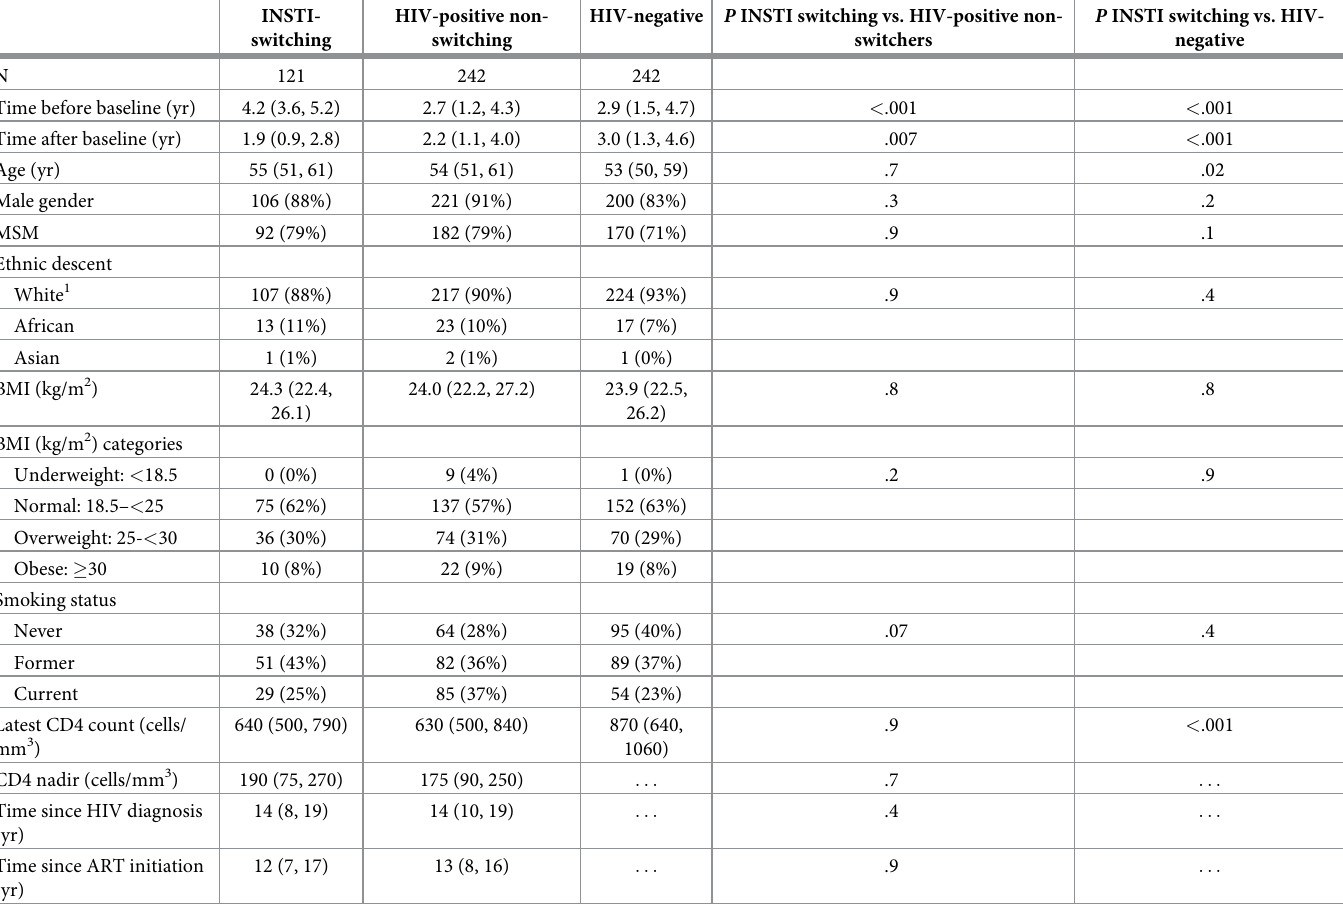
(Table 1). The only significant difference was found in median age of HIV-negative controls compared to index-group participants (53 vs. 55 years respectively, P = .02). HIV-specific char- acteristics, such as current and nadir CD4 count and time between diagnosis and ART Table 1. Characteristics of INSTI-switching, HIV-positive non-switching and HIV-negative selected study groups at baseline. INSTI- HIV-positive non- HIV-negative P INSTI switching vs. HIV-positive non- P INSTI switching vs. HIV- switching switching switchers